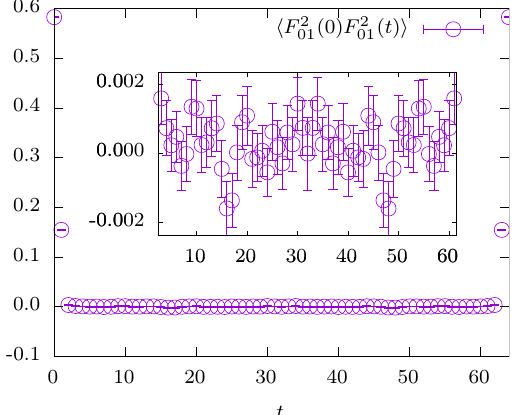
Figure 13. Glueball correlation function C ( t ) as function of the temporal extend t for (cid:12) = 17 and m f = (cid:0) 0 :